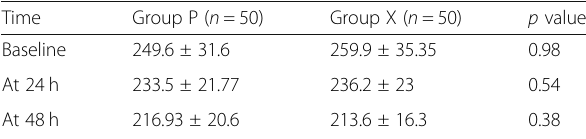
Table 2 Weight-based nomogram for continuous intra-vascular UFH infusion Anti-Xa Dose adjustment